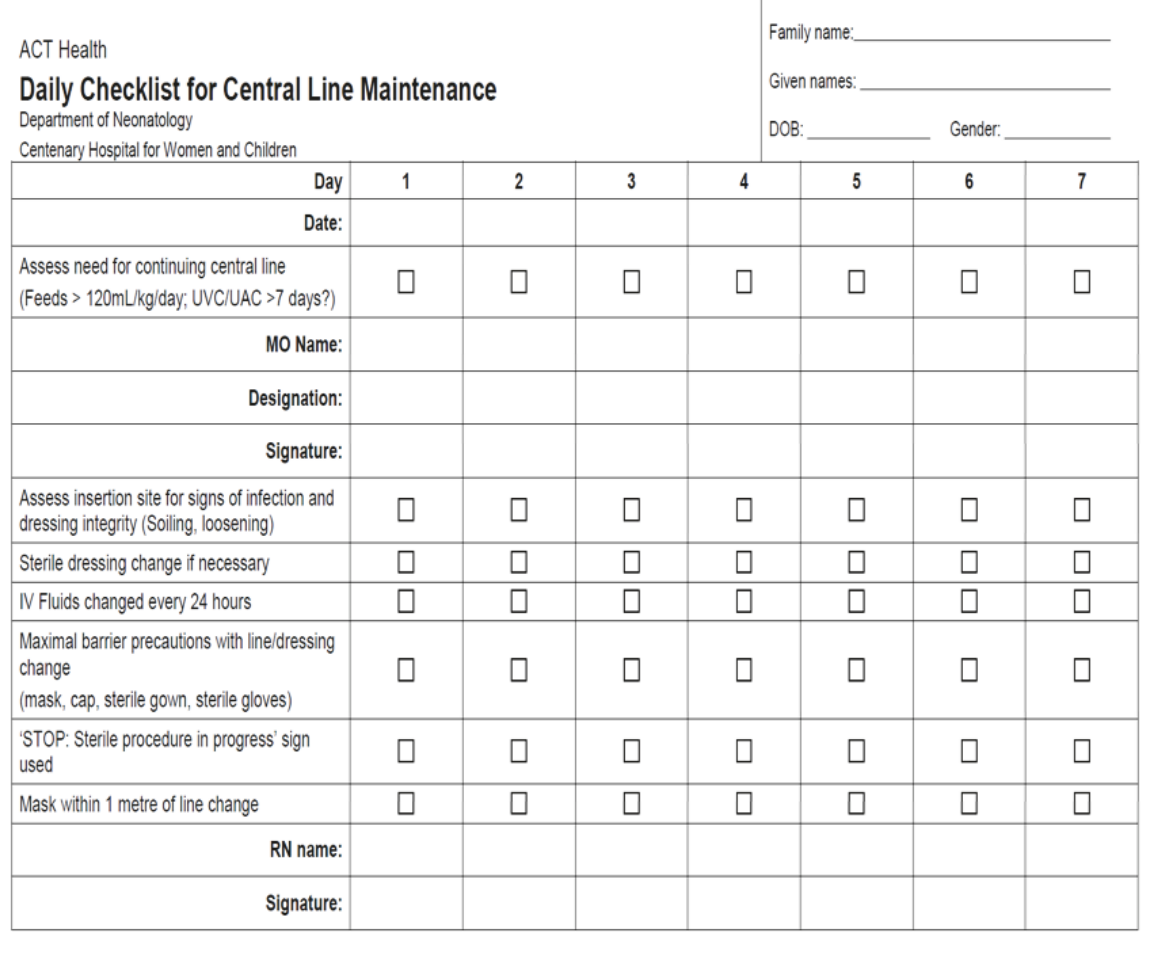
Figure 2: Daily checklist for central line